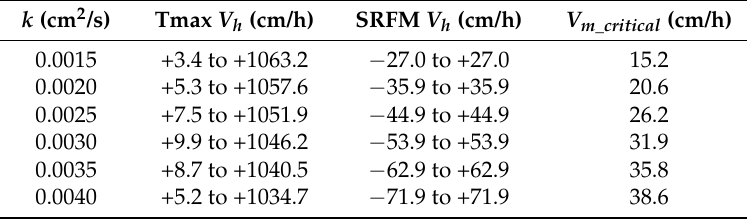
Table 1. The theoretical heat velocity ( V h ) measurement range for the Tmax and heat ratio method (HRM), also known as the “slow rates of flow” method (SRFM), at varying sapwood thermal diffusivity ( k ). The V h values are based on a probe spacing ( x ) of 0.6 cm and a 3 s heat pulse ( t 0 ). The minimum data from Tmax is based on a one-second measurement resolution and Equation (3). The theoretical SRFM calculation is based on a ∆ T d / ∆ T u ratio of 20 and Equation (4). V m_critical was calculated via Equation (10). k (cm 2 /s) Tmax V h (cm/h) SRFM V h (cm/h) V m_critical